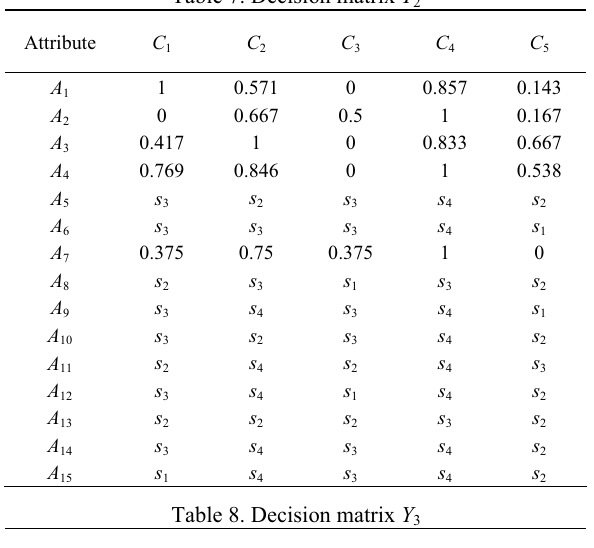
Table 5. Original decision matrix X 3